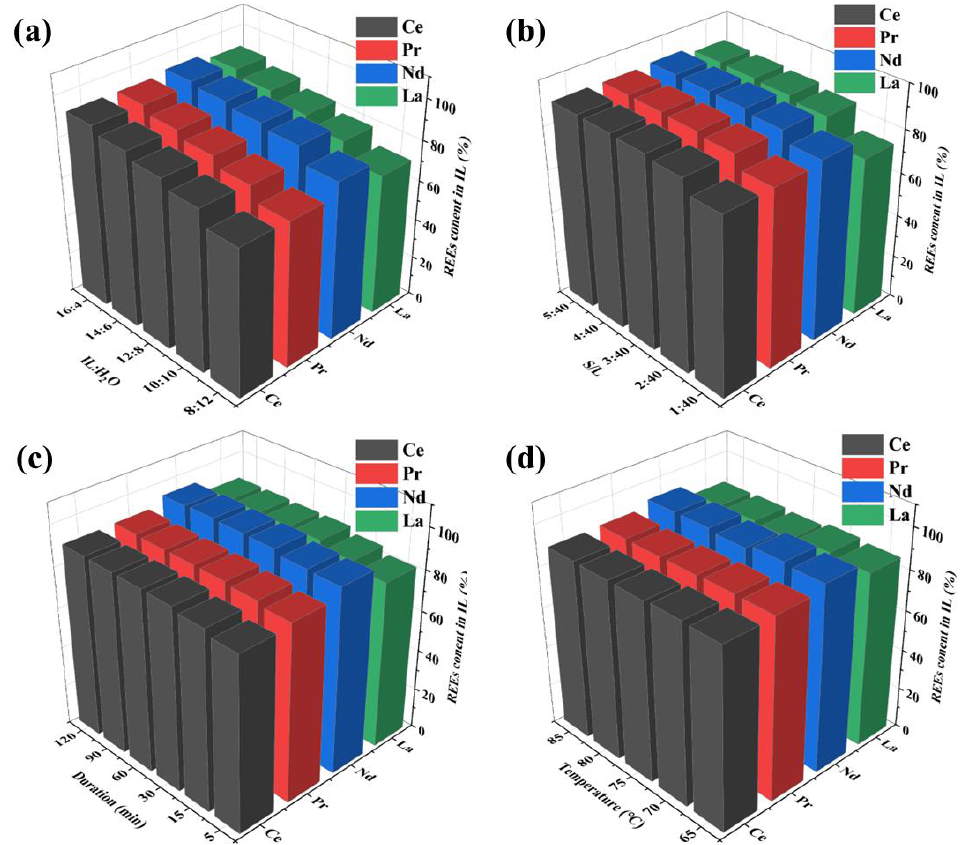
Figure 9. The distribution of REEs in the ionic liquid and aqueous phase after leaching with different leaching conditions, [Hbet][Tf 2 N]:H 2 O ( a ), S/L ratio ( b ), reaction duration ( c ), and temperature ( d ). 3.4. Back Extraction of [Hbet][Tf 2 N] Loaded with REEs